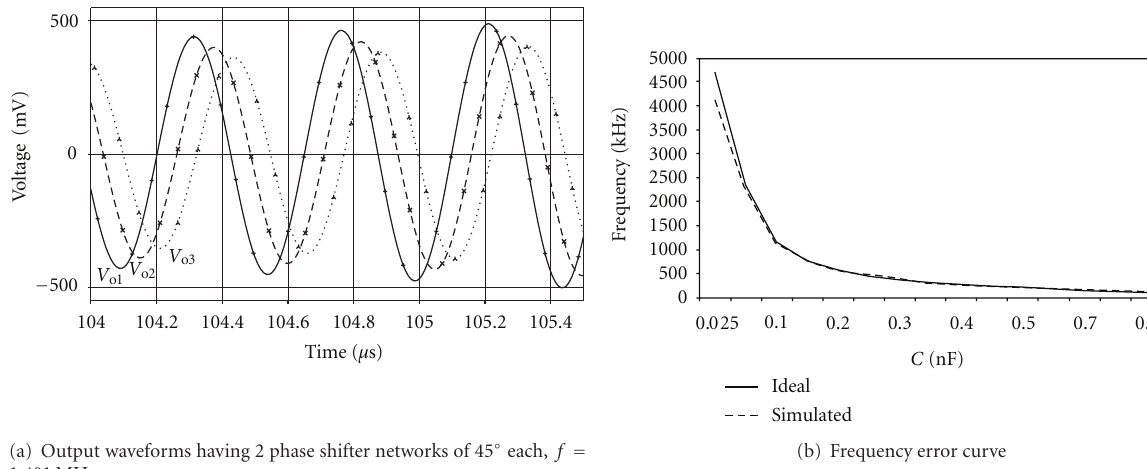
Figure 9: Simulation result for circuit III.